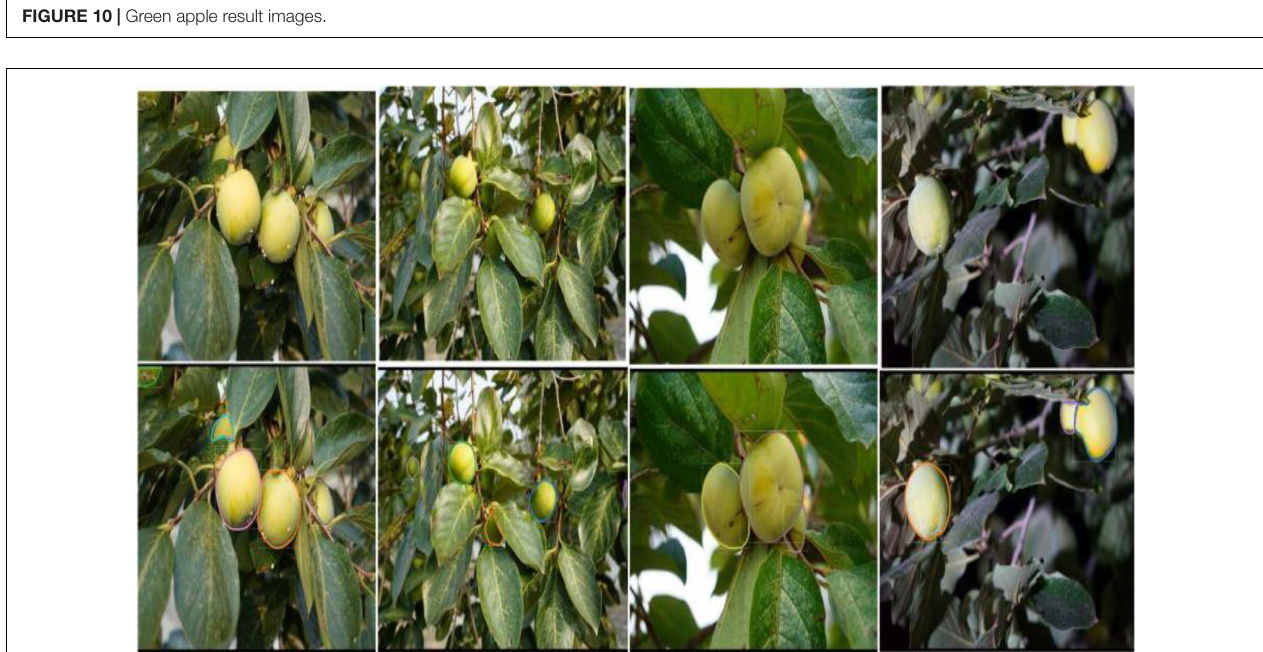
FIGURE 10 | Green apple result images.